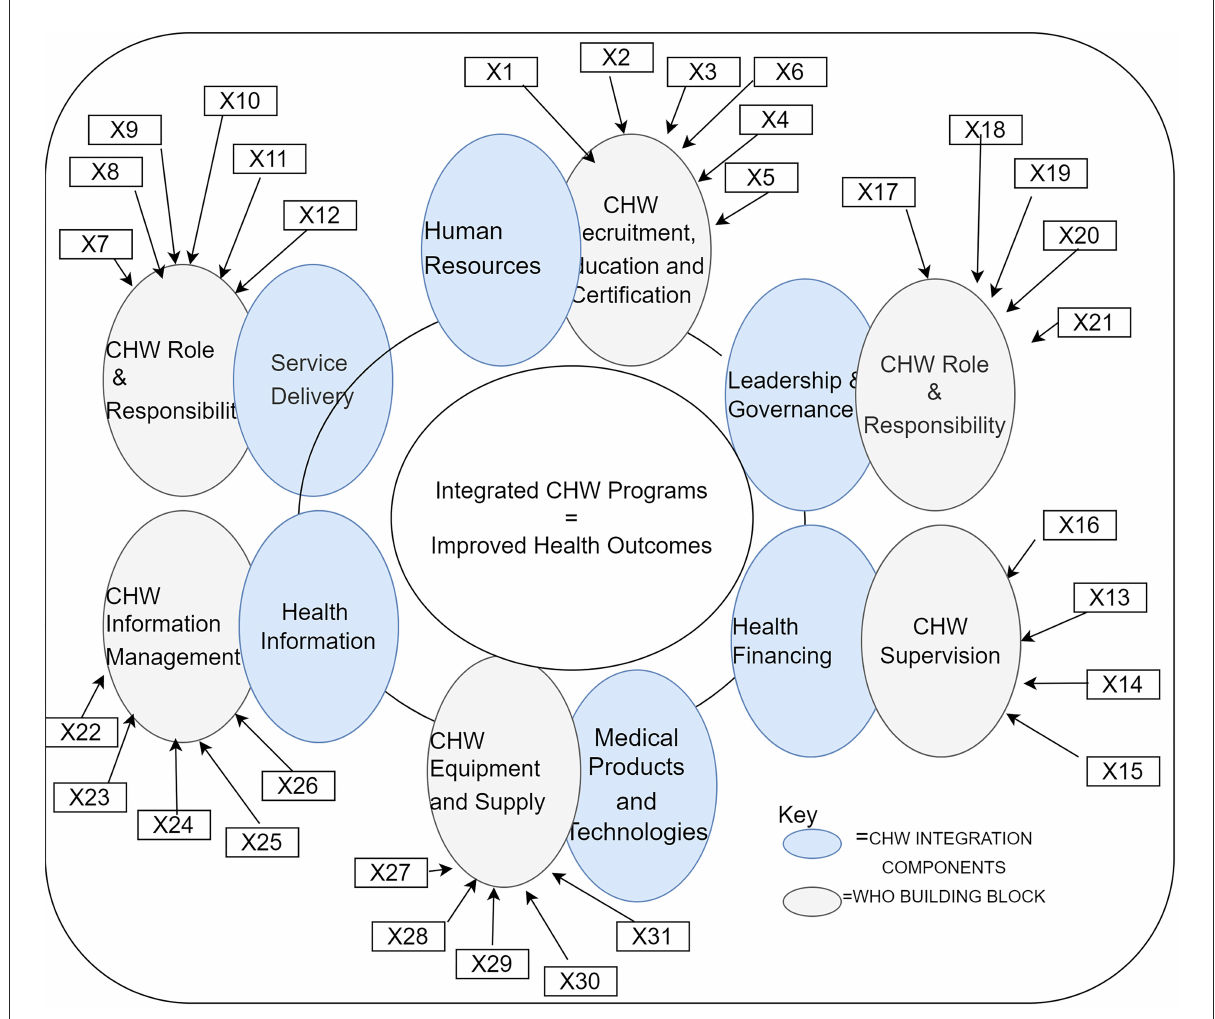
FIGURE1 Study conceptual framework (X1–X31 as indicated in Table 1). Source: Adapted from the study by Mupara and Mogaka